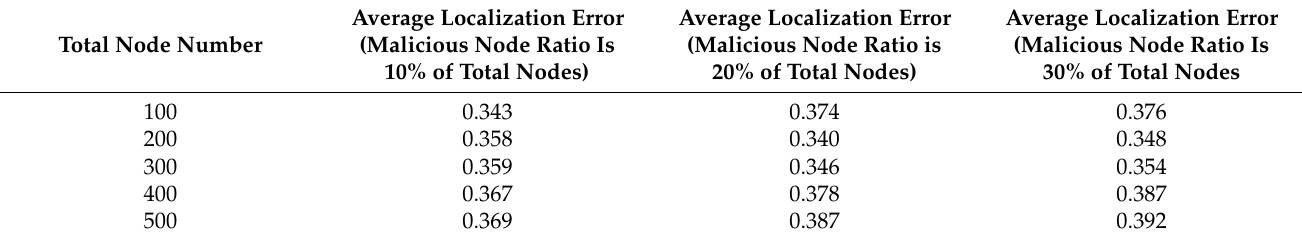
Table 5. Average localization error under the impact of malicious nodes corresponding to the anchor node ratio.